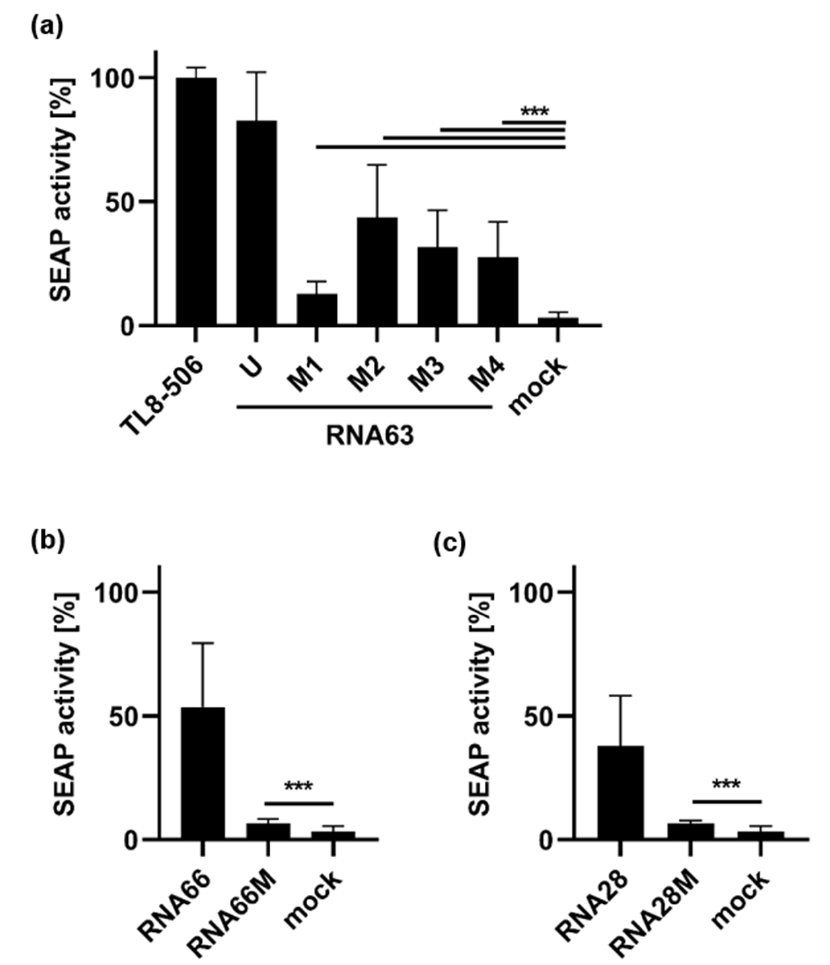
Figure 5. Oligoribonucleotides with 2 (cid:48) -O-ribose methylation activate TLR8. HEK-TLR8 cells were stimulated with TLR8-specific TL8-506 at 0.5 µ g/mL and different derivatives of ( a ) RNA63 (U = unmethylated), ( b ) RNA66, or ( c ) RNA28 at a final concentration of 20 µ g/mL or mock-treated. Cell supernatant was mixed with QUANTI-Blue™ medium at 20 h p. s. for 15 min at 37 ◦ C. Secreted embryonic alkaline phosphatase (SEAP) activity, reflecting NF- κ B activation, was determined by colorimetric measurement at 650 nm and results were normalized to TL8-506-induced NF κ B activation. Graphs depict six independent experiments each in biological duplicates (twelve measurements per data point, mean + S.D). Data were analyzed using Wilcoxon tests. *** p < 0.001. In summary, a single 2 (cid:48) -O-methylation, tested at different positions within the RNA, converted RNA63 from a TLR7/TLR8 ligand into an exclusive TLR8 ligand. However, 2 (cid:48) -O-methylations at different guanosine positions resulted in different strengths of TLR7 inhibition and TLR8 activation, although it was observed for all positions tested. In